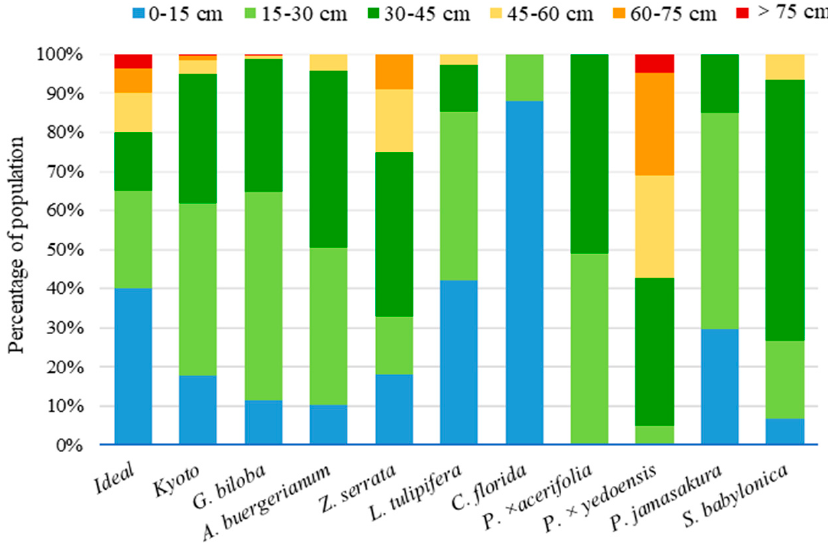
Figure 2. Diameter at breast height (DBH) size distribution of predominant street tree species compared to an “ideal” distribution [65]. Note: The “Kyoto” classification represents the total of the sampled street trees.